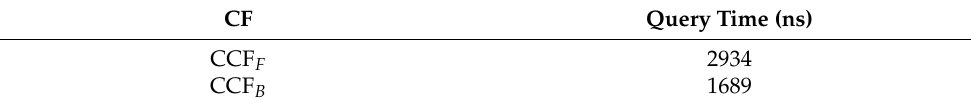
Table 3. The query overhead of CCF F and CCF B